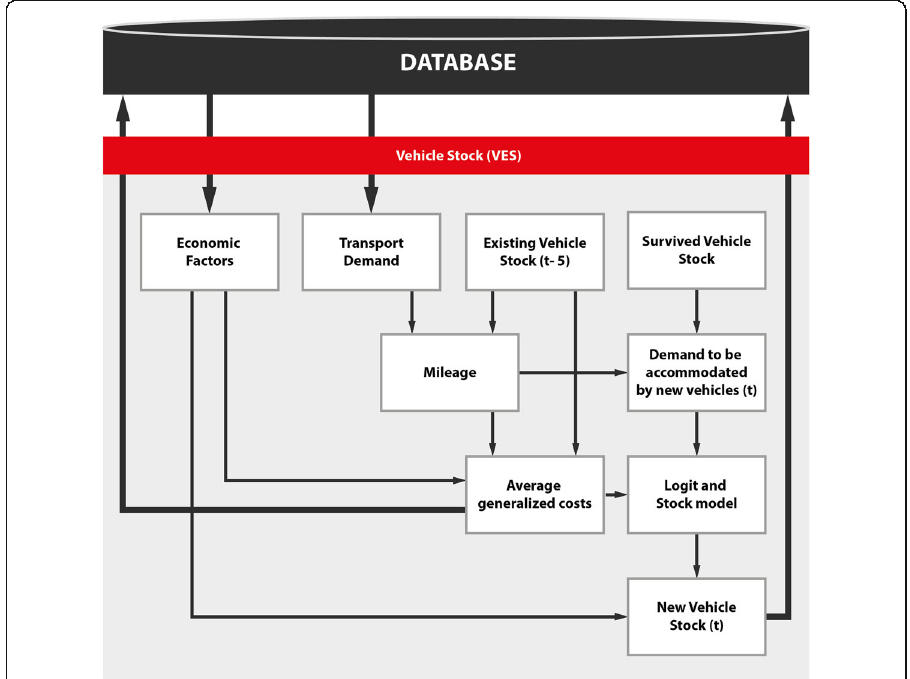
Fig. 4 Structure of the Vehicle Stock